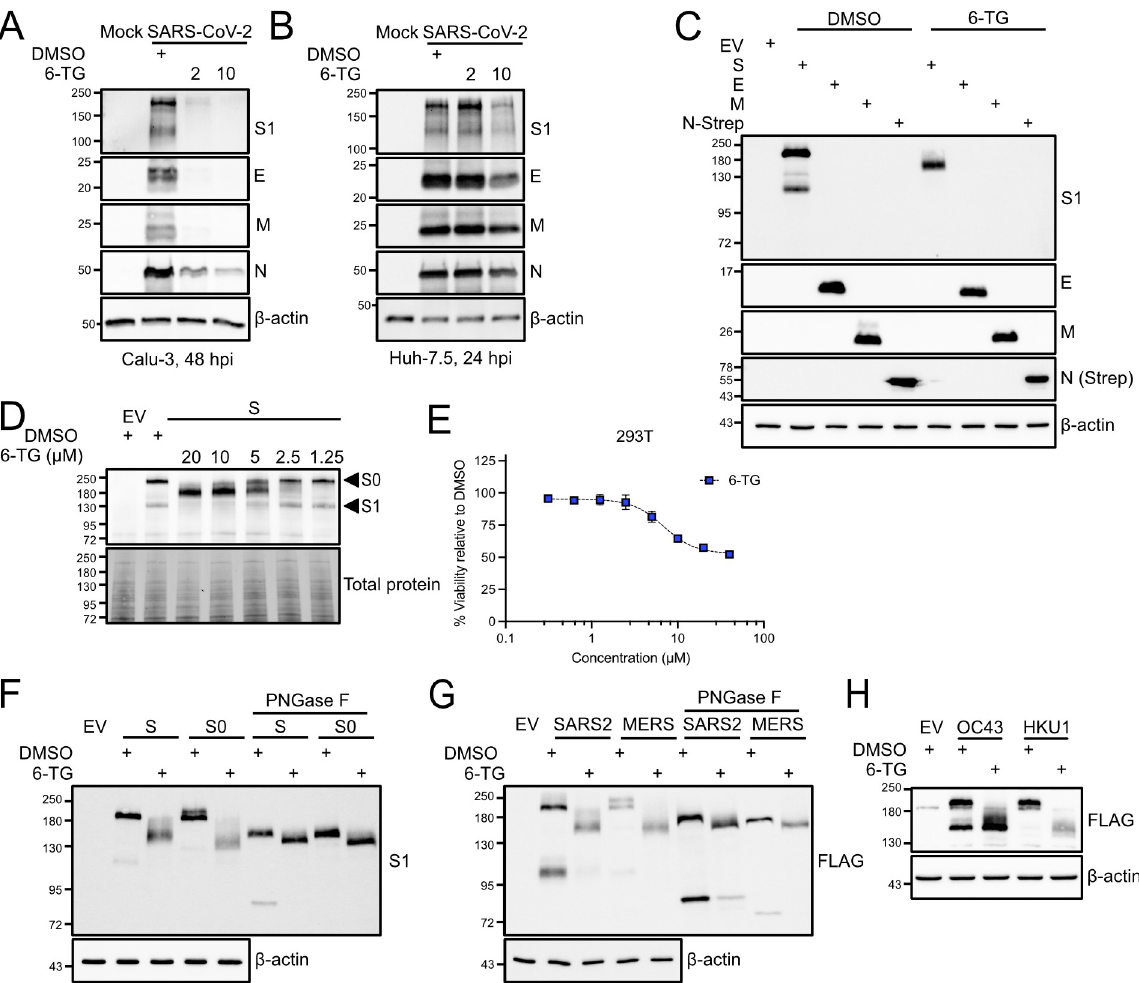
Fig 3. 6-TG inhibits Spike glycosylation and cleavage. (A) Calu-3 cells were infected with SARS-CoV-2 at an MOI of 7, then treated with 6-TG or DMSO. Lysates were harvested 48 h after infection and were probed by western blotting as indicated. Concentrations in legend are in μ M. (B) Huh-7.5 cells were infected with SARS-CoV-2 at an MOI of 5, then treated with 6-TG or DMSO. Lysates were harvested 48 h after infection and were probed by western blotting as indicated. Concentrations in legend are in μ M. (C) 293T cells were transfected with plasmids encoding SARS-CoV-2 Spike (S), Membrane (M), Envelope (E), Nucleoprotein (N) with a C-terminal 2xStrep tag, or empty vector (EV) then treated with 10 μ M 6-TG or DMSO vehicle control. Lysates were harvested 24 h after transfection and probed by western blotting as indicated. (D) 293T cells were transfected with SARS-CoV-2 Spike or EV then treated with 6-TG or DMSO vehicle control. Lysates were harvested 24 h after transfection and were probed by western blotting as indicated. Concentrations in legend are in μ M. (E) AlamarBlue cell viability assay of 6-TG treated 293T cells (n = 3 ± SEM). (F) 293T cells were transfected with plasmids encoding SARS-CoV-2 Spike, a Spike mutant lacking the Furin cleavage site between S1 and S2 (S0), or EV then treated with 10 μ M 6-TG or DMSO vehicle control. Lysates were harvested 24 h after transfection, treated with PNGase F to remove N-linked glycans, and probed by western blotting as indicated. (G) as in (C) except 293T cells were transfected with plasmids encoding C-terminal FLAG-tagged Spike (S-FL) or HCoV-MERS Spike (MERS). (H) as in (C) except 293T cells were transfected with plasmids encoding FLAG-tagged Spike from HCoV-OC43 (OC43) or HCoV-HKU1 (HKU1). polypeptide chain (unless the core GlcNAc is modified with α -1,3-fucose) [51]. PNGase F treatment caused Spike from DMSO-treated cells to migrate similarly to Spike from 6-TG- treated cells (Fig 3F). We confirmed the identity of the high MW Spike band as the uncleaved S0 precursor protein by generating and testing a mutant Spike protein in which the basic resi- dues in the furin cleavage site joining S1 and S2 were substituted with alanines, yielding a pro- tease cleavage-resistant Spike protein. 6-TG treatment revealed that the S0 construct was also